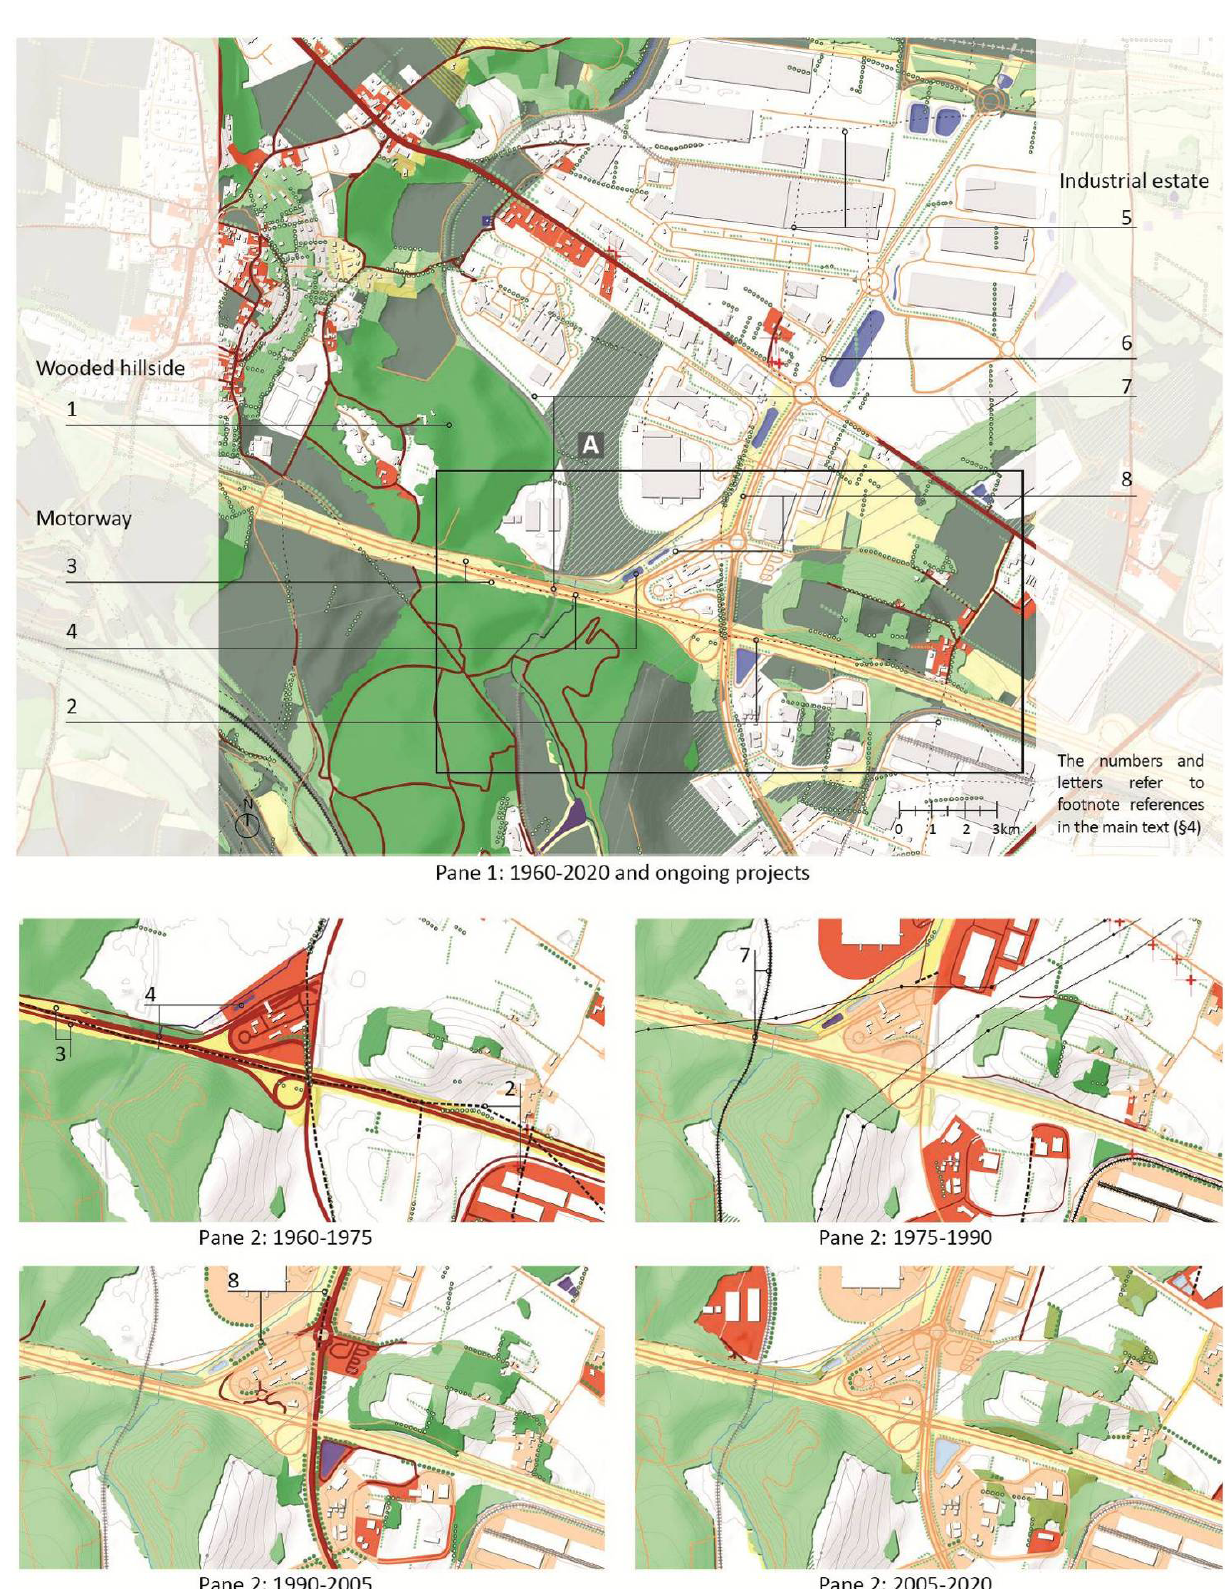
Figure 6. Extract 1 from the palimpsest mapping: The wooded hillside Grenay (east of the industrial estate). Source: Author.